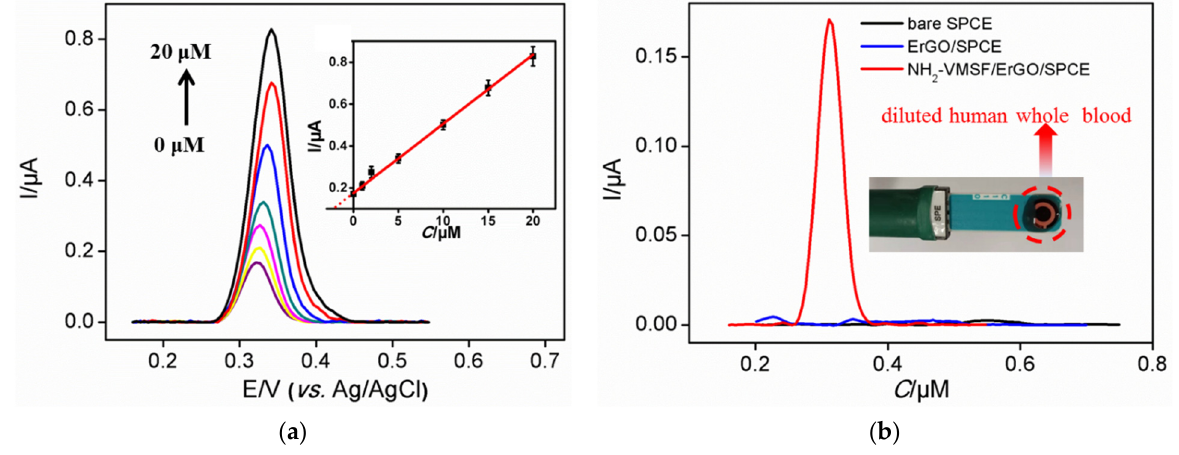
Figure 7. ( a ) Differential pulse voltametric curves obtained on NH 2 -VMSF/ErGO/SPCE in diluted human whole blood with the addition of different concentrations of UA (From bottom to top: 0; 1; 2; 5; 10; 15; 20 μ M). Inset is the corresponding calibration curve. ( b ) Differential pulse voltametric curves obtained on NH 2 -VMSF/ErGO/SPCE or ErGO/SPCE in diluted human whole blood. Inset is the digital image of the NH 2 -VMSF/ErGO/SPCE sensor and the detected blood sample. Table 1. Determination of UA in diluted human whole blood samples.